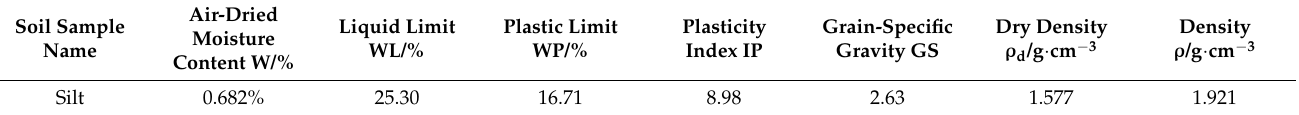
Table 1. Basic physical parameters of silt.